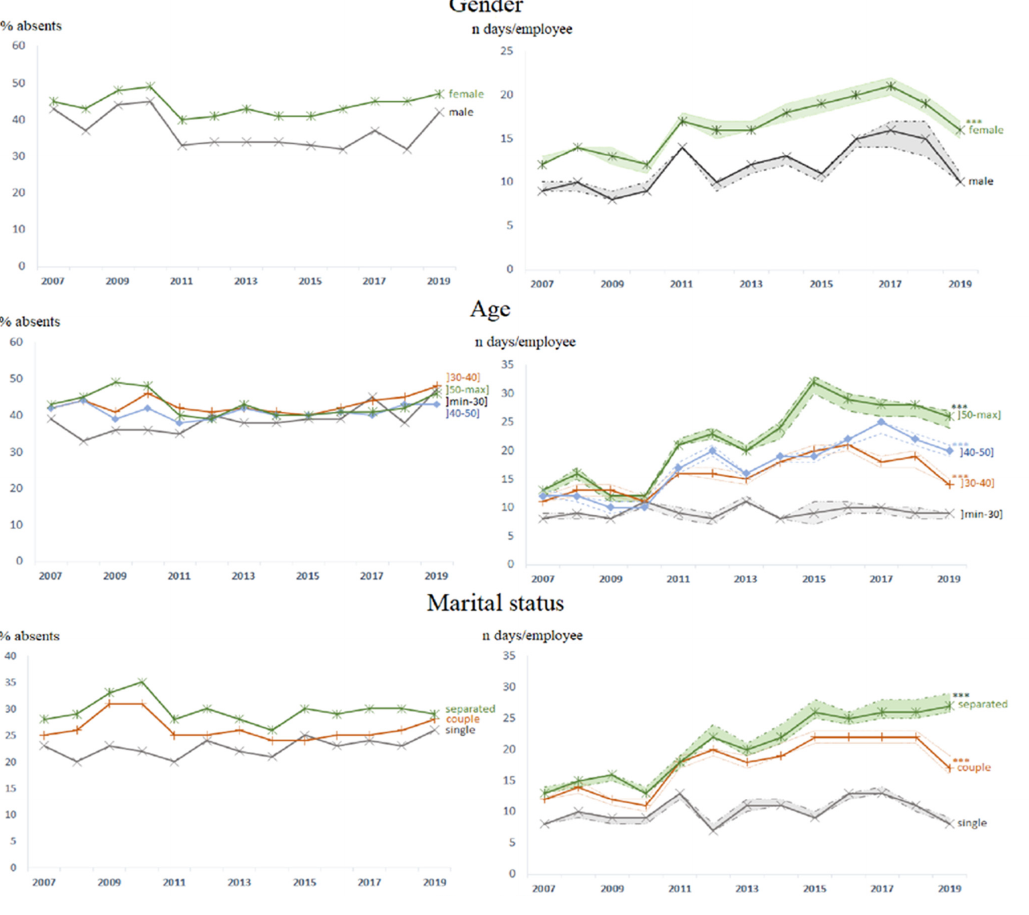
Figure 3. Evolution of the proportion of absentees and the number of days of absence per absent agent by sociodemographic factor (expressed in median (C49–C51)).